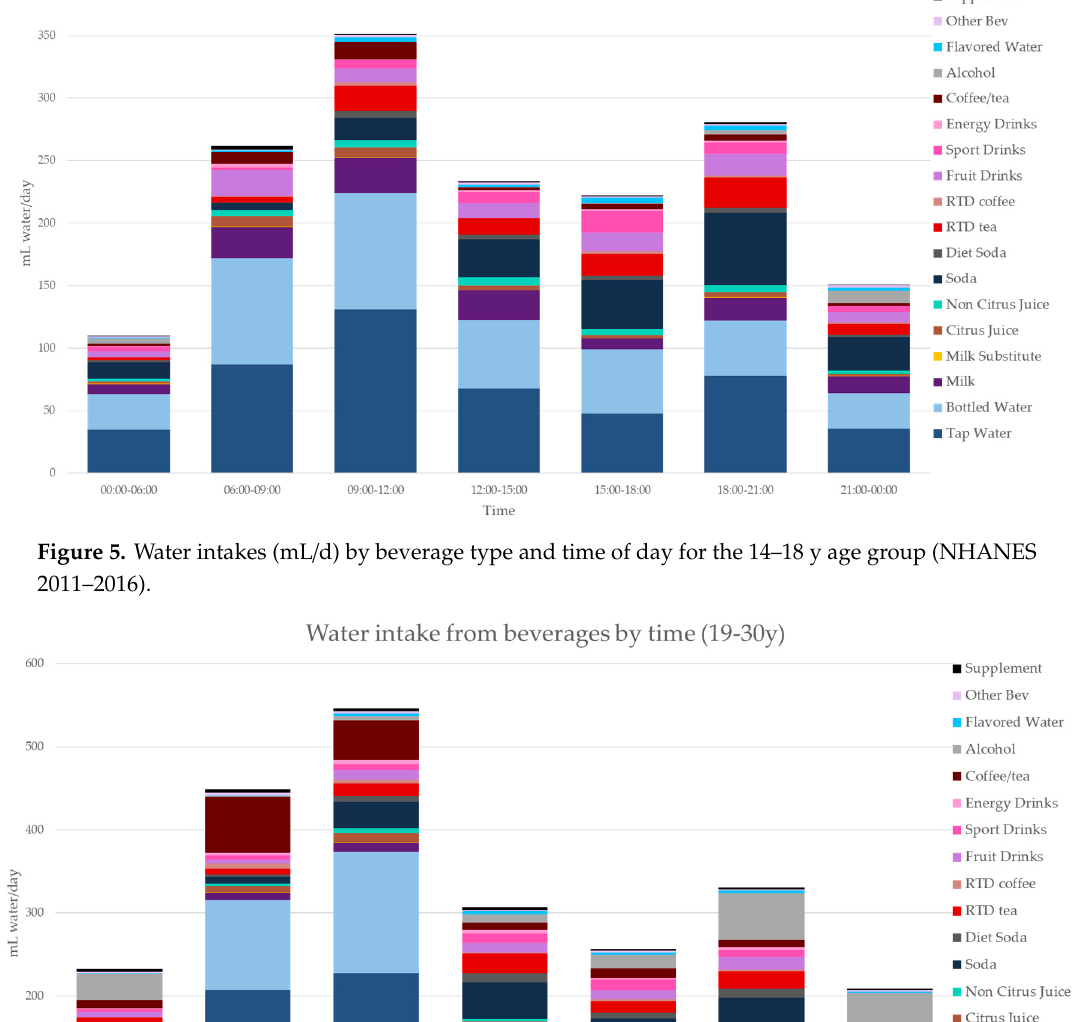
Figure 4. Water intakes (mL/d) by beverage type and time of day for the 9–13 y age group (NHANES 2011–2016).